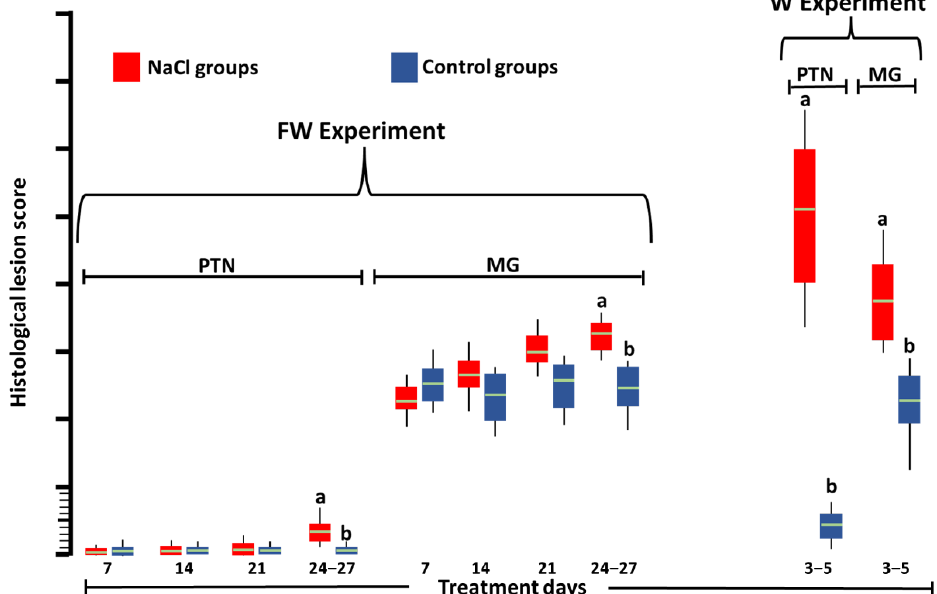
Figure 1. Scores of acute proximal tubular necrosis (PTN) and mesangioproliferative glomerulopathy (MG) in Leghorn SPF chickens at 27 days of treatment with 3.3% NaCl in feed and del 22–27 days 3.3% NaCl in drinking water (FW experiment) or at 5 days of 1% NaCl in drinking water (W experiment). Different letters above boxes in the same experiment and lesion denote significant dif- ferences ( P < 0.05). Green line: median.